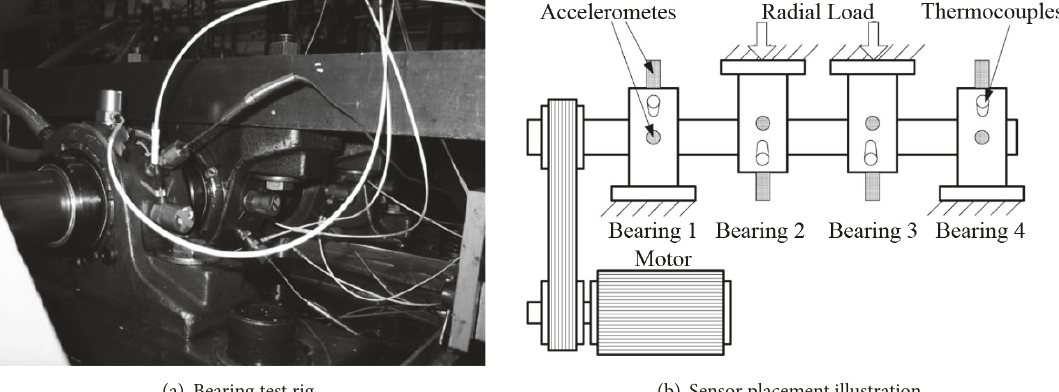
Figure 2: Bearing test rig and sensor placement illustration.